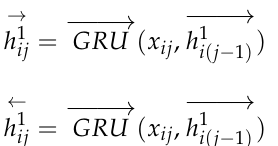
network. Secondly, the SGRU network is sliced into subsequences of equal length. The sequence length T is 8, and the length of the smallest subsequence is 2. Then x i is the i -th text and x ij is the word vector of the j -th word in the i -th text. Through the slicing